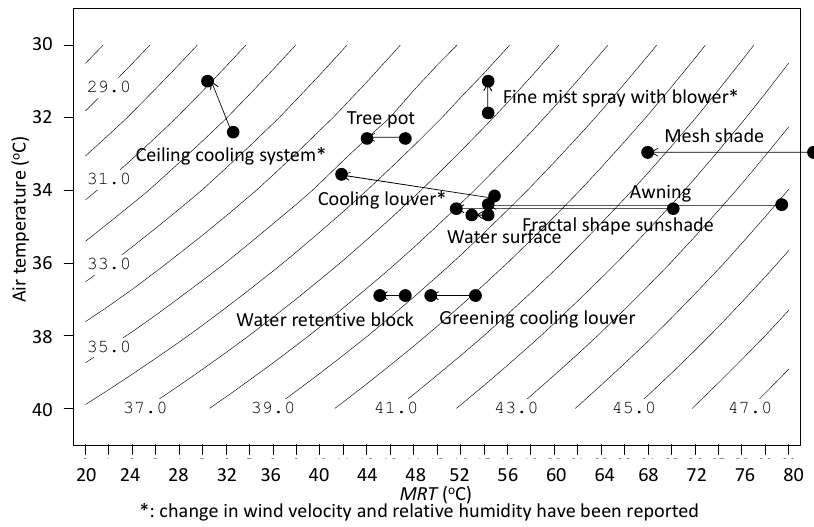
Figure 6. Examples of the effects of adaptation measures obtained through demonstrative experiments. The background SET* is the same as that in Figure 5.